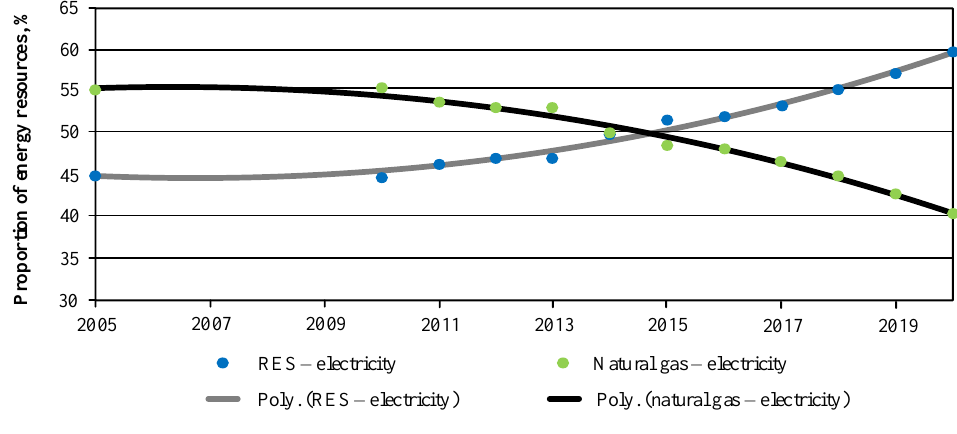
Fig. 2. Energy resources for electricity